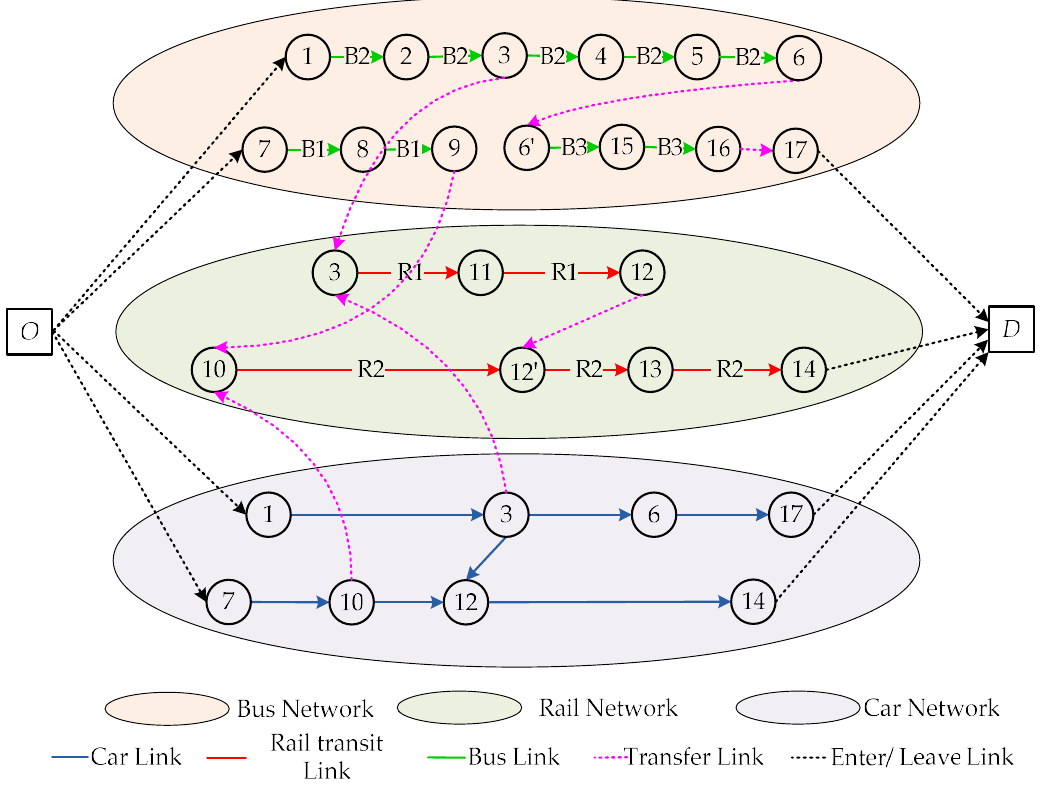
Figure 9. The multimodal transportation super network